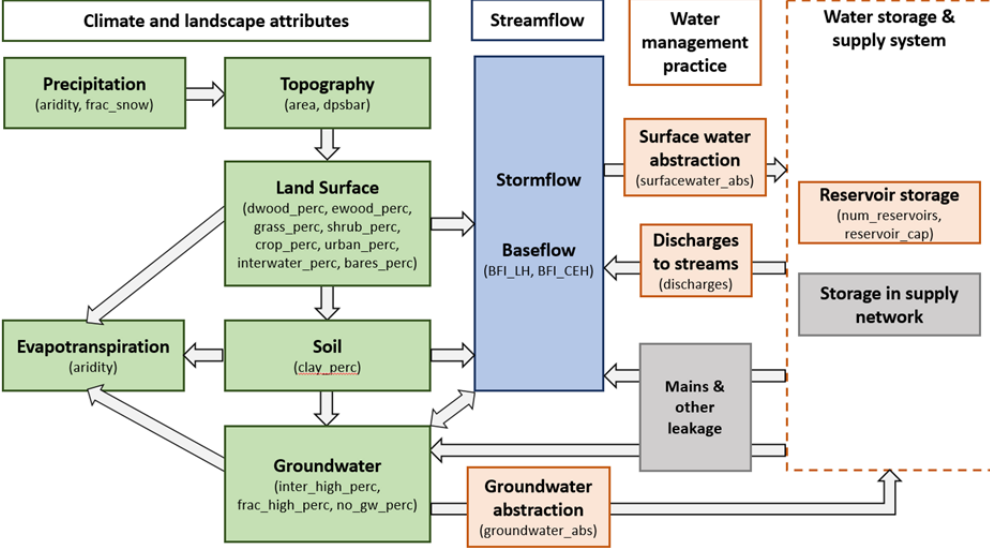
Figure 4. Conceptual model of the relationships between the major compartments of the terrestrial water cycle that exert an influence on baseflow. Baseflow and storm flow components are highlighted in blue, driving climatology, catchment characteristics and compartments are shaded in green, and human influences within the conceptual model are shaded in orange and grey (the latter outside the scope of this study). The 21 CAMELS-GB covariates and the two BFI parameters used in this study are listed against their respective compartments within the conceptual